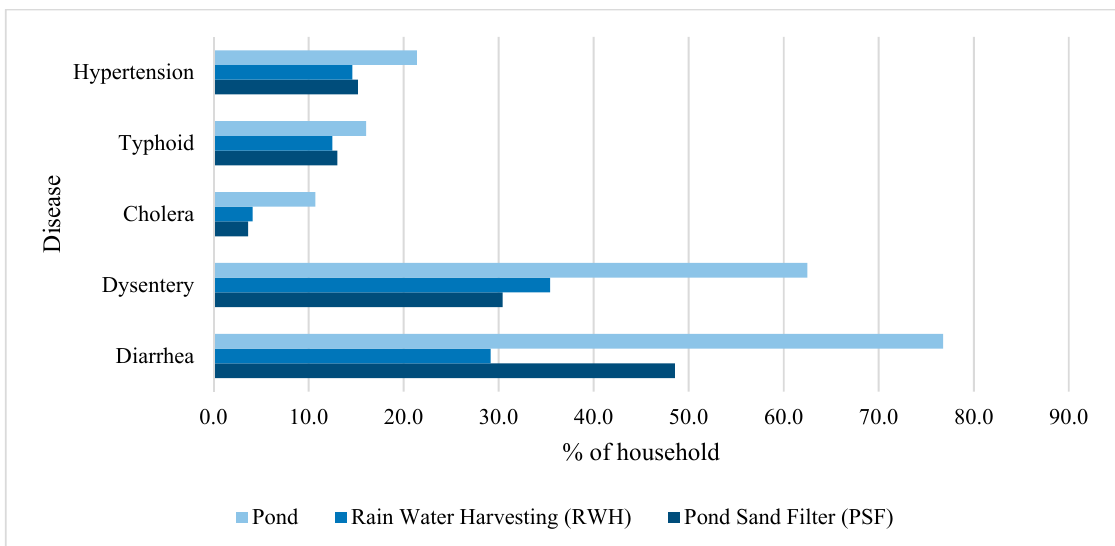
Figure 2. Water treatment facilities in households of Southkhali Union.